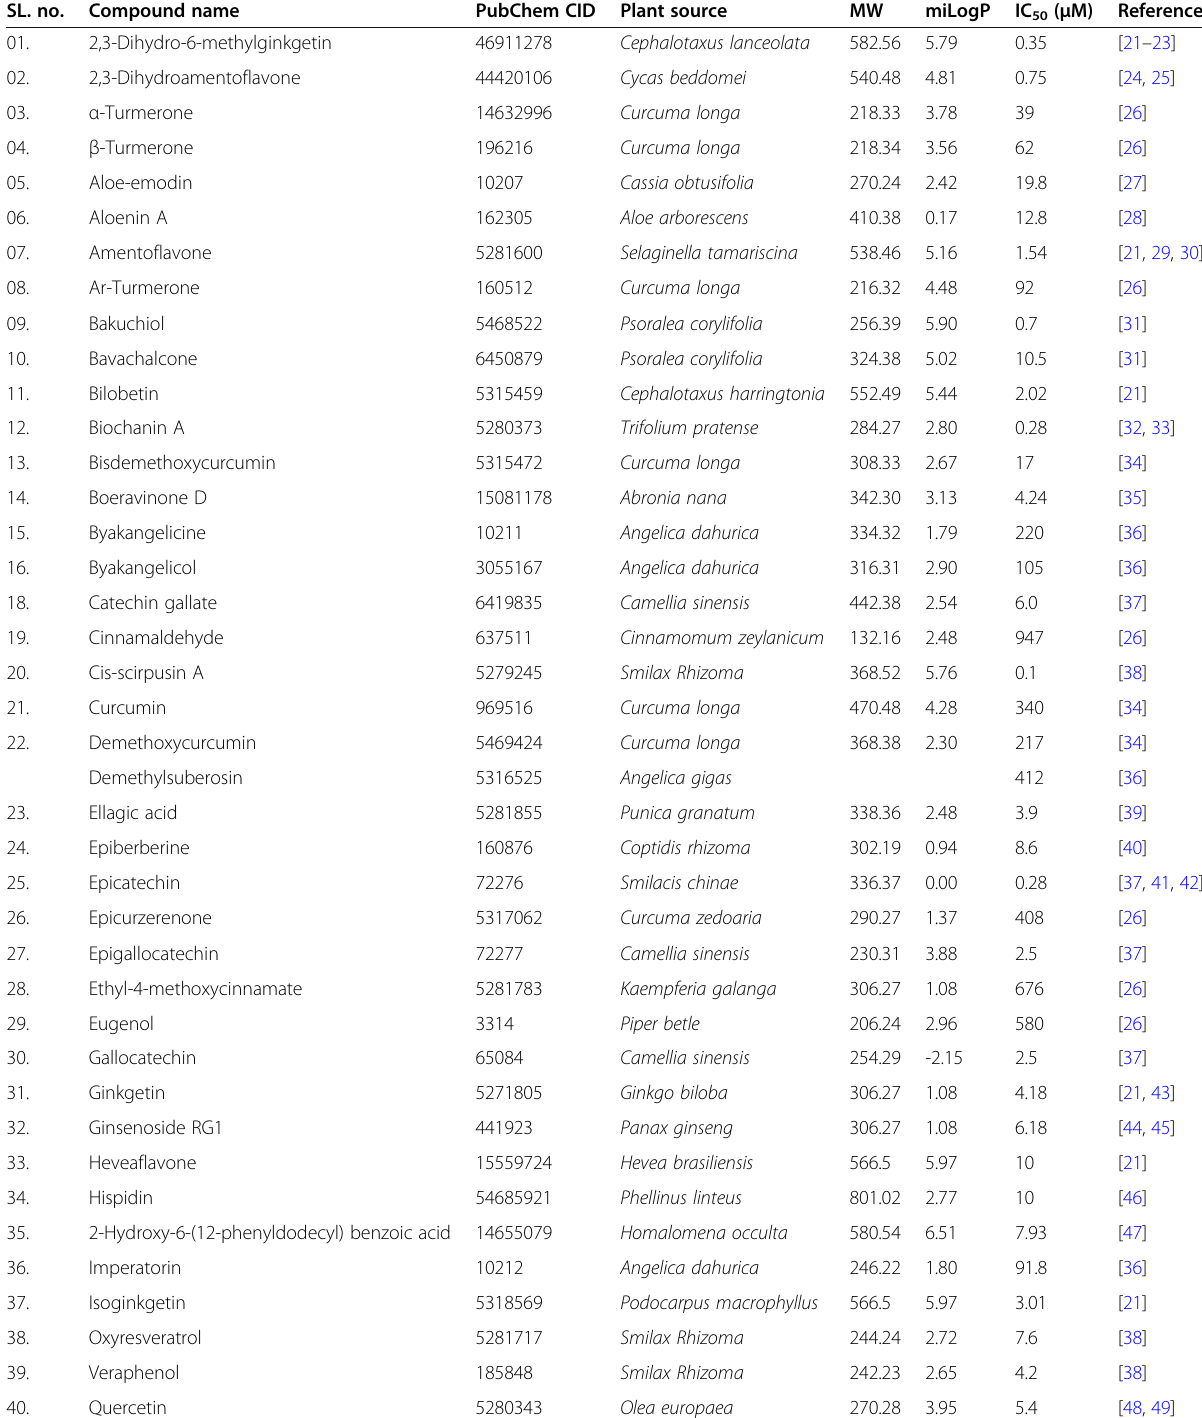
Table 1 Selected phytocompounds known to inhibit β -secretase from different plants. MW molecular weight. (Molecular weight was calculated from Molinspiration Cheminformatics server;